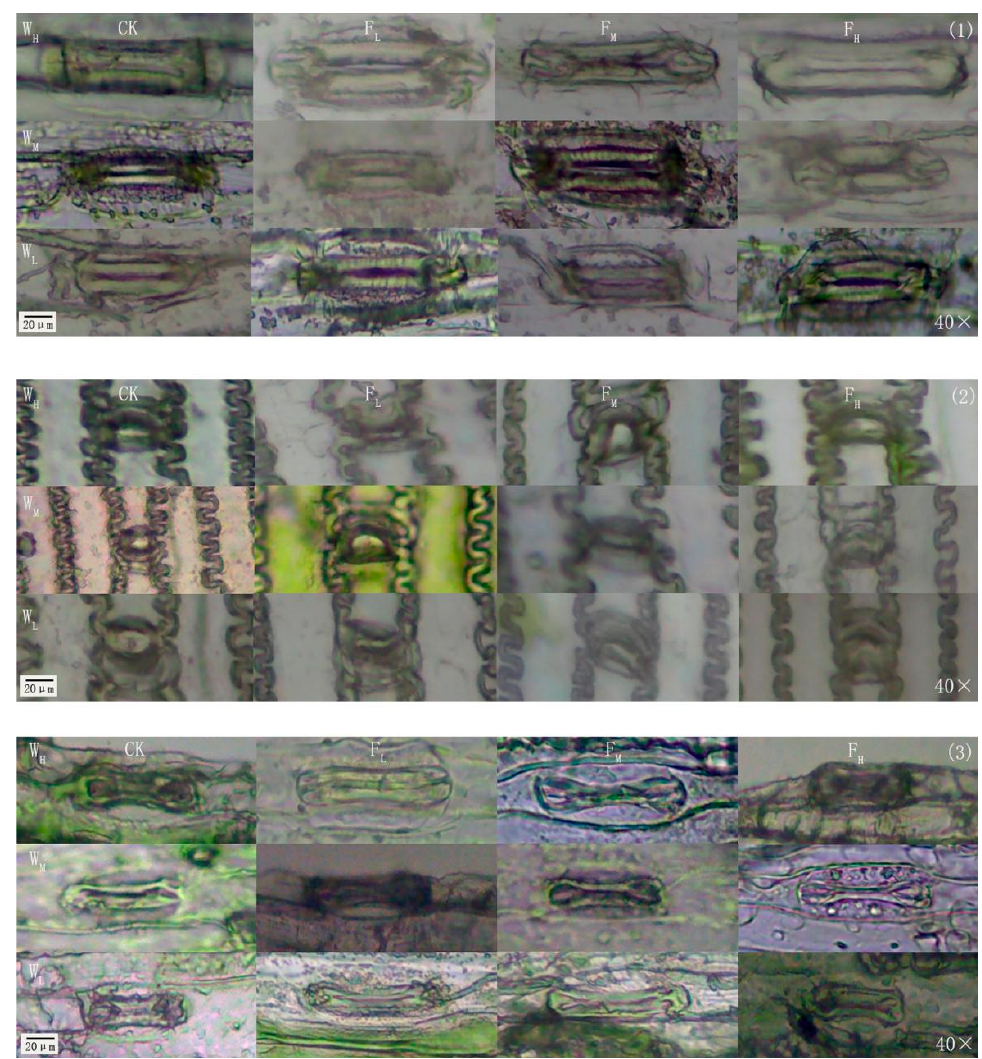
Figure 10. Changes in stomatal size values of test plant species under different water–fertilizer treat- ments. Numbers ( 1 ) − ( 3 ) in brackets indicate P. crymophila , F. coelestis , and S. purpurea, respectively .